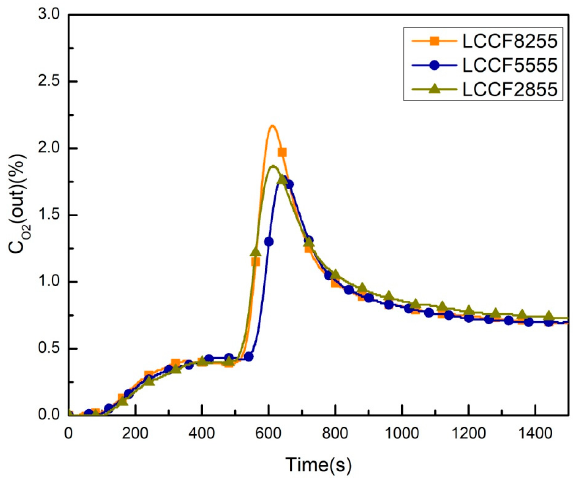
Figure 6. Oxygen desorption curves of La 1-x Ca x Co 0.5 Fe 0.5 O 3- δ (x = 0.2, 0.5, 0.8).